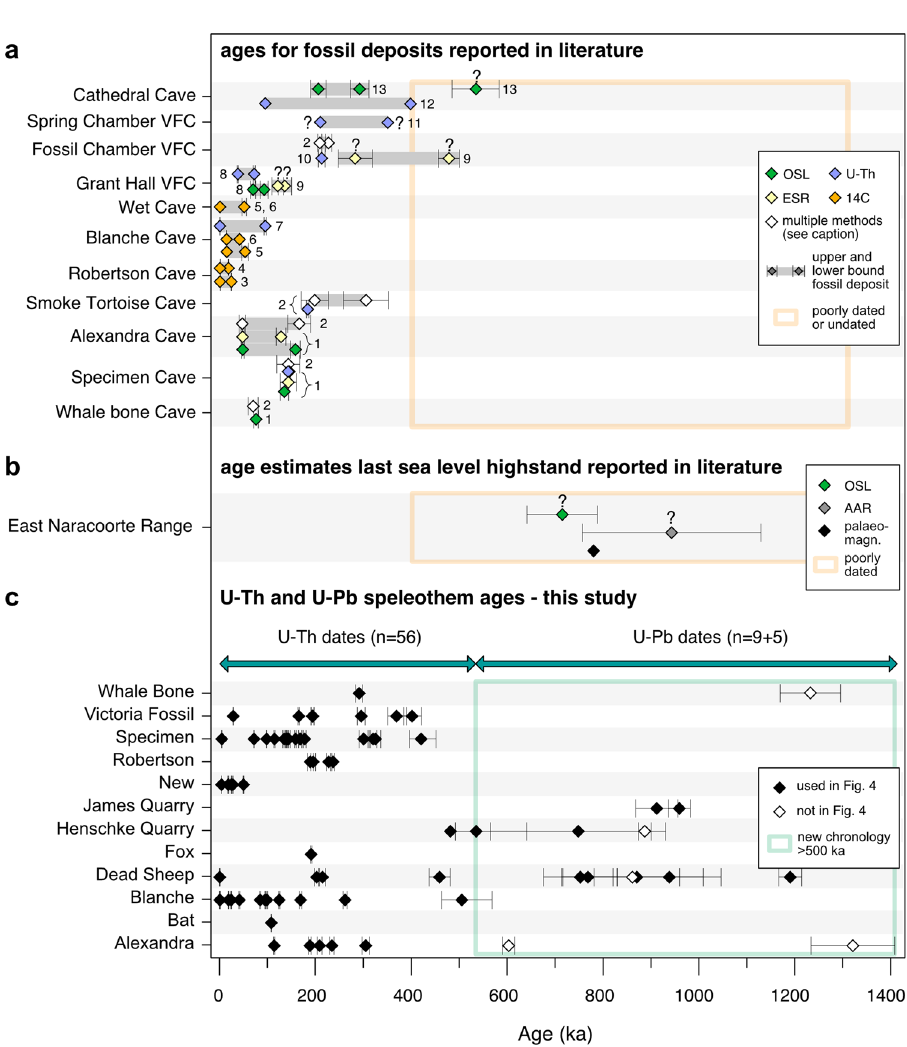
Fig. 2 Overview of published and new chronological data for the Naracoorte Cave Complex (NCC). a Published ages for the fossil deposits from ten caves within the NCC. VFC Victoria Fossil Cave, 1. Priya et al. 15 , 2. Arnold et al. 16 , 3. Atkins et al. 12 , 4. Grealy et al. 60 , 5. Macken et al. 61 , 6. Darrenougue et al. 62 , 7. St Pierre et al. 63,64 , 8. Macken et al. 65 , 9. Grün et al. 66 , 10. Ayliffe et al. 31 , 11. Moriarty et al. 17 , 12. Brown and Wells 67 , 13. Prideaux et al. 13 . Grey bars show the range between the upper and lower age estimates of each fossil layer. All age uncertainties (whiskers) are reported as 2 σ . Note that several age estimates were reported without age uncertainties. b Published ages for deposition of the East Naracoorte Range (see text). c New U-Th and U-Pb speleothem ages and their 2 σ uncertainties (whiskers) from this study. Note that 5 U-Pb ages (open boxes) were not analysed for charcoal and pollen content and are excluded from